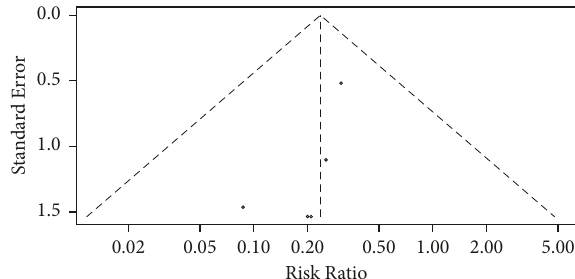
Figure 7: Funnel plot analysis of incidence indicators of bladder perforation.